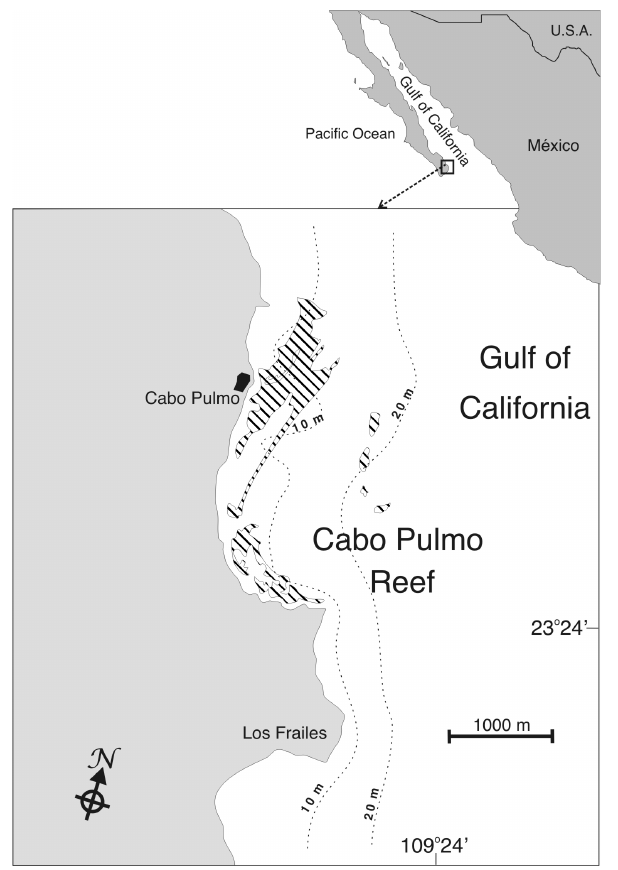
Fig. 1. Location of Cabo Pulmo reef (hatched area), at the mouth of the Gulf of California,